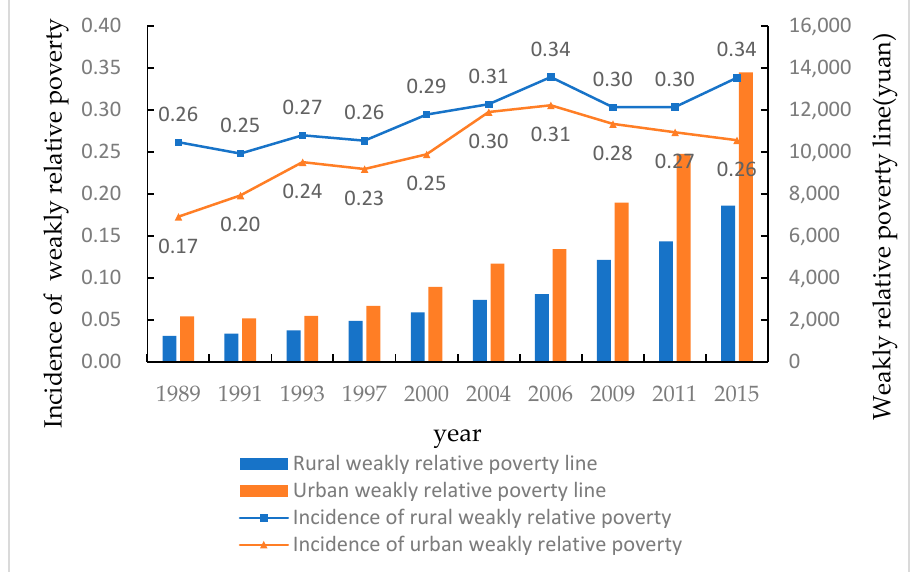
Figure 3. Weakly relative poverty in urban and rural areas from 1989 to 2015. Similar to the movement in national relative poverty, regardless of rural or urban areas, strongly relative poverty—50% of the mean income poverty line and poverty inci ‐ dence rose the most among the three types of relative poverty, followed by weakly relative poverty, and strongly relative poverty—50% of median income rose the least. Relative poverty in urban and rural areas also shows a trend of low fluctuation (1989–1997) ‐ rising (1997–2006) ‐ high fluctuation (2006–2015). Among the three kinds of relative poverty measurement results, the urban relative poverty line has always been higher than that of rural areas, with an average of 1.6 times that of rural areas, but the incidence of urban relative poverty was lower than that of rural areas. The above results show that most rural households are at a lower income level and suffer more severe relative poverty compared to urban areas. In addition, the changing trend of the incidence of relative poverty in rural areas almost coincides with that in the whole country. Rural relative poverty directly af ‐ fects the relative poverty of the whole country, and the key areas to alleviate relative